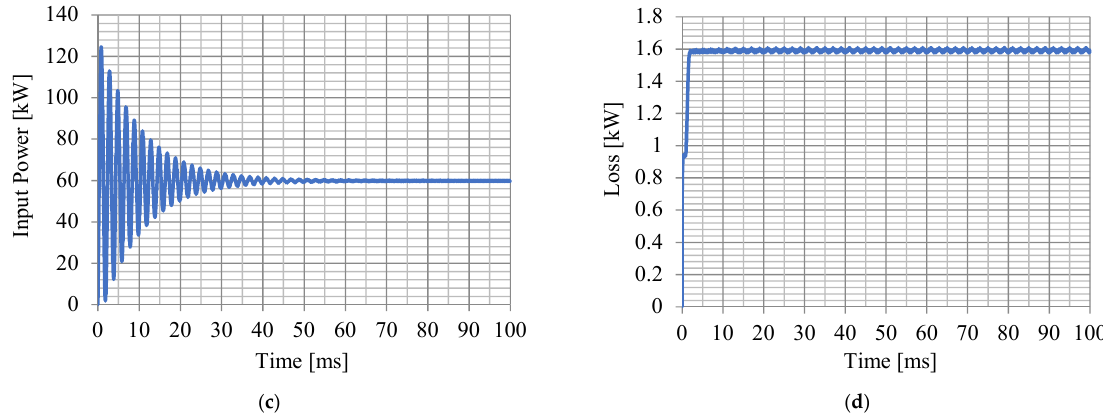
Figure 11. Characteristics at 30 krpm (60 kW electric driven mode): ( a ) Input voltage. ( b ) Input current. ( c ) Input power. ( d ) Loss.